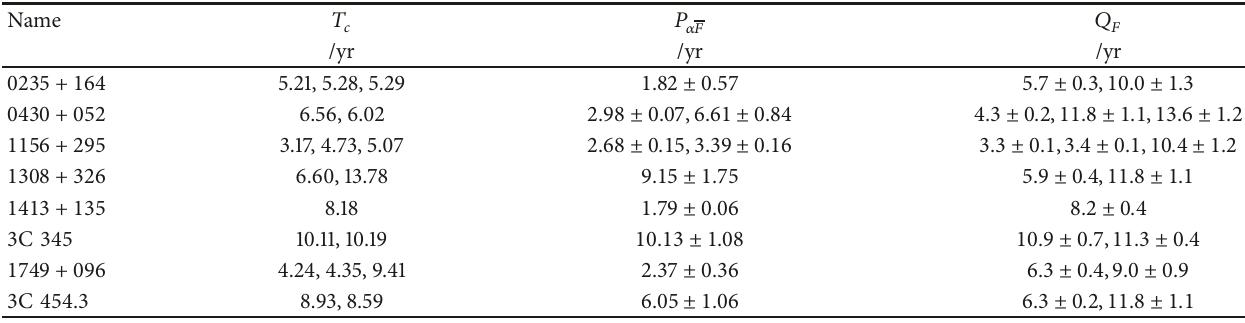
Table 4: The time spans and long-term quasi-periodicities of 8 blazars.